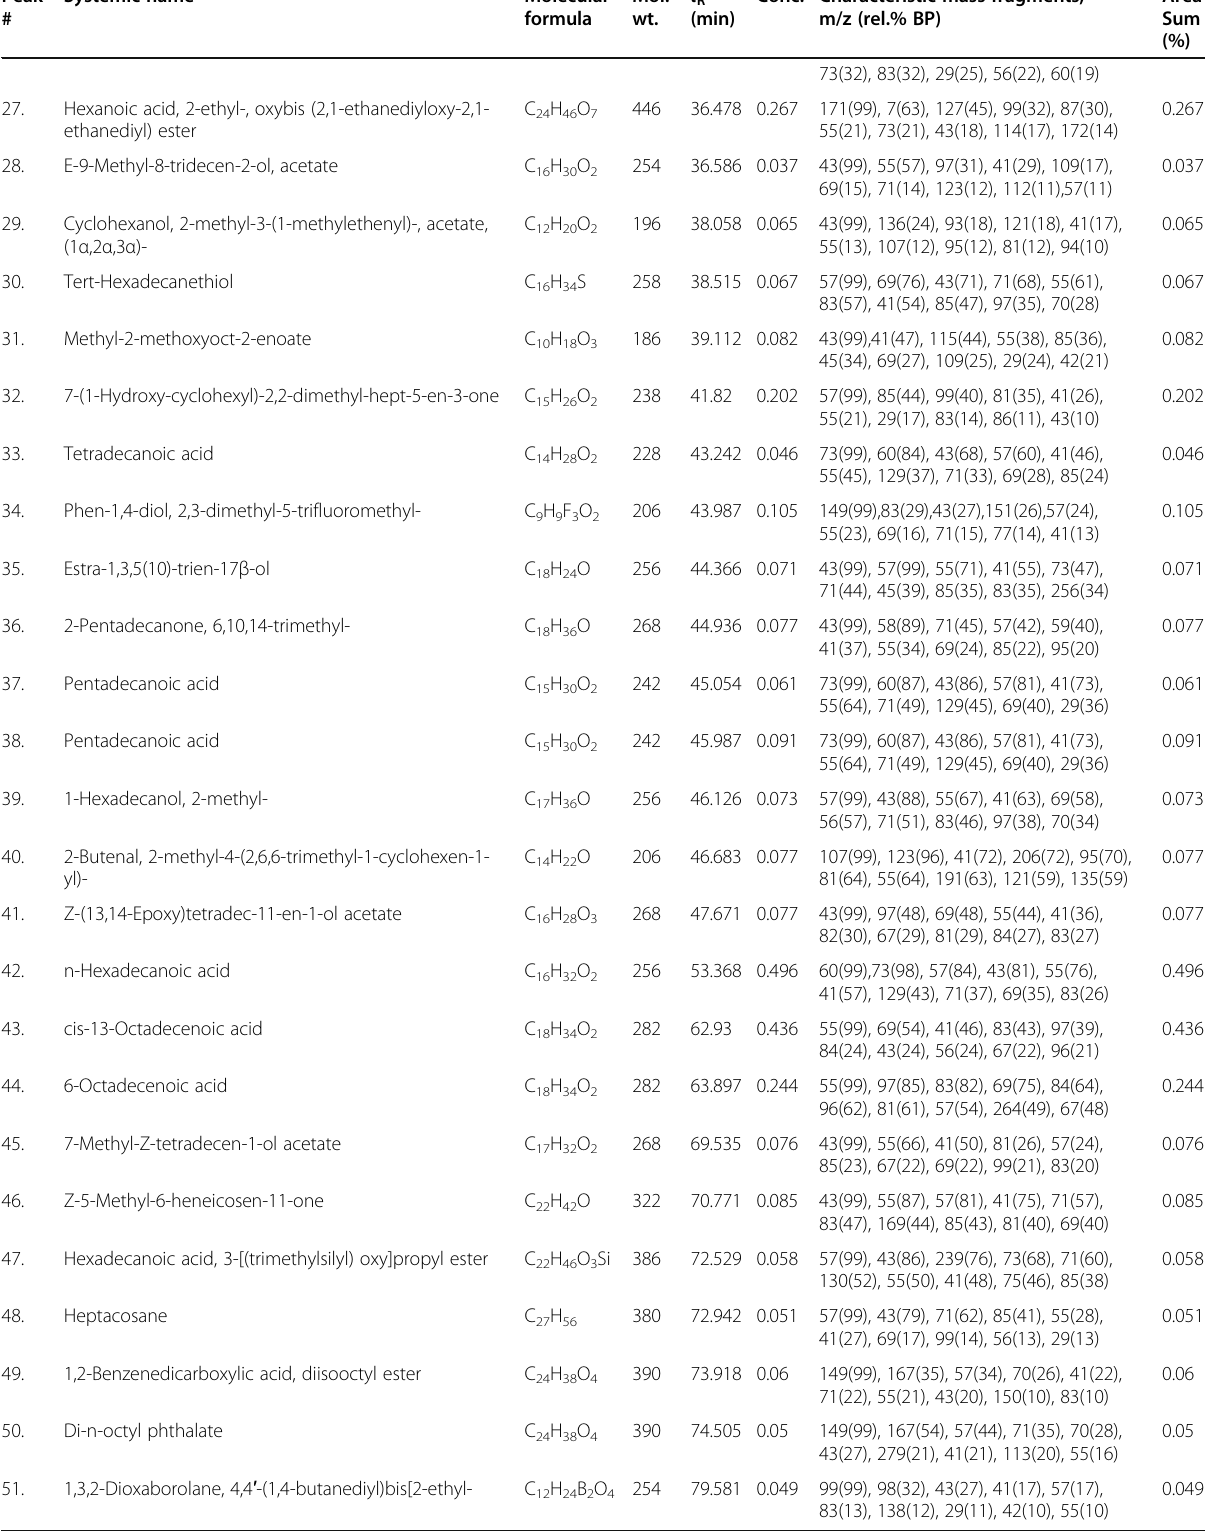
Table 5 Spectral data of n -hexane soluble fraction of Sargassum ilicifolium (Continued) Peak Systemic name Molecular #